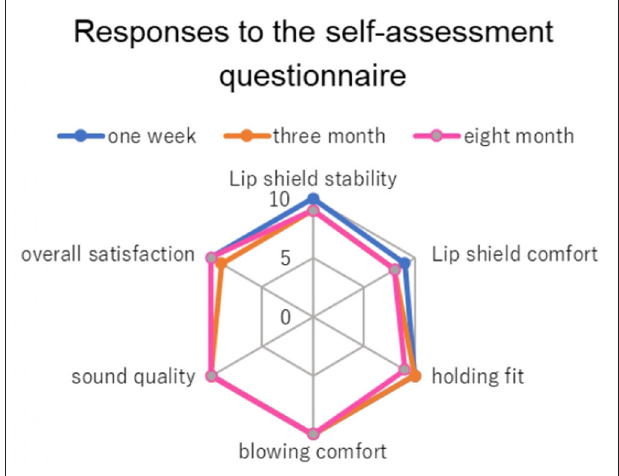
FIGURE 4 | The results of the self-evaluation questionnaire, with items rated using a 10-point scale, at 1 week, 3 months, and 8 months. A score of 10 indicates good and 0 indicates